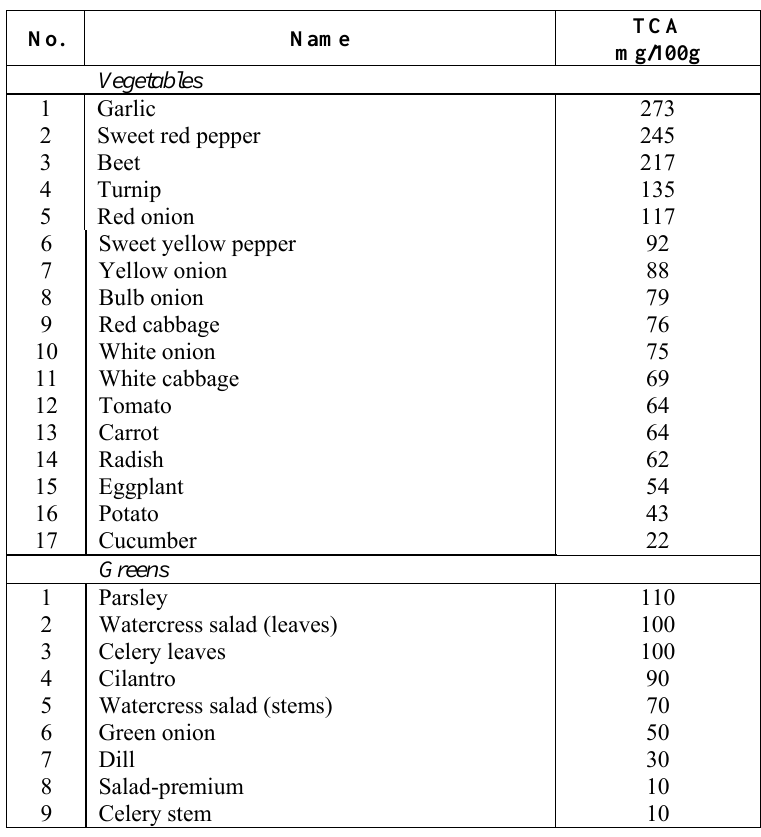
Table 2. Total Content of Antioxidants (TCA) in Vegetables and Greens (quercetin – standard).